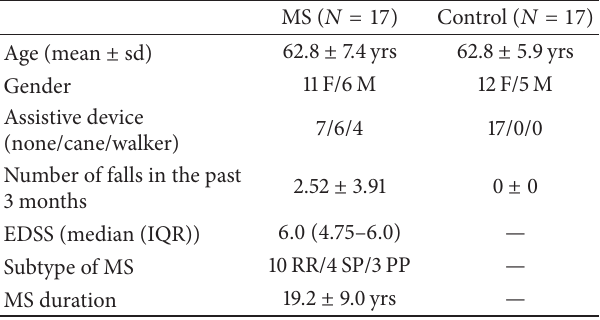
Table 1: Participant characteristics for the MS and control